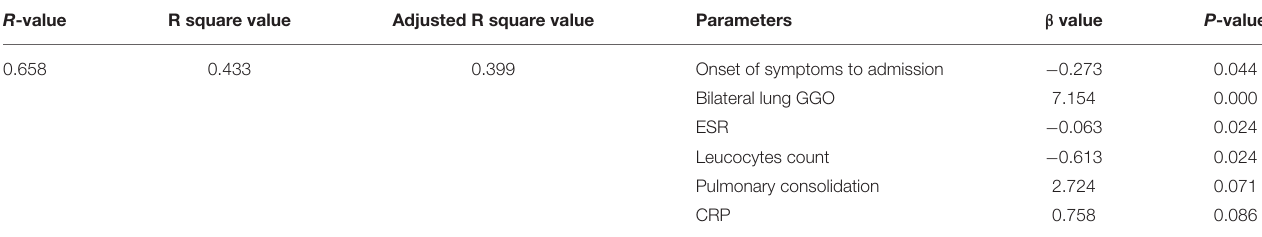
TABLE 5 | Relevant factors of the length of hospitalization.